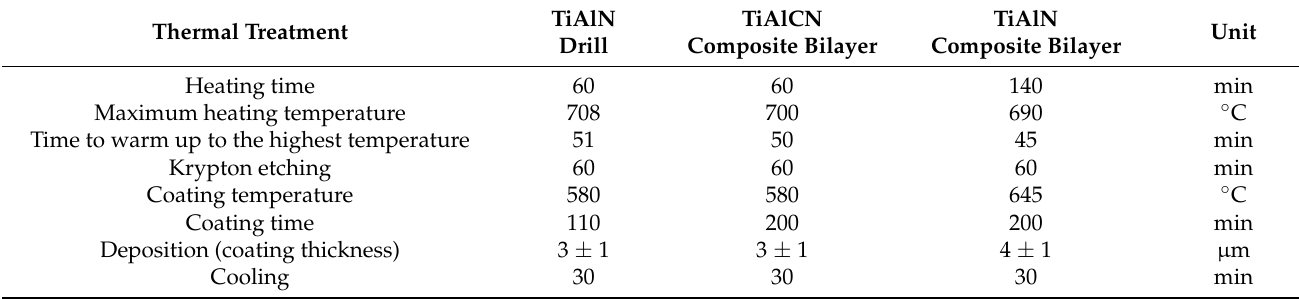
Table 3. Comparison of coating conditions.